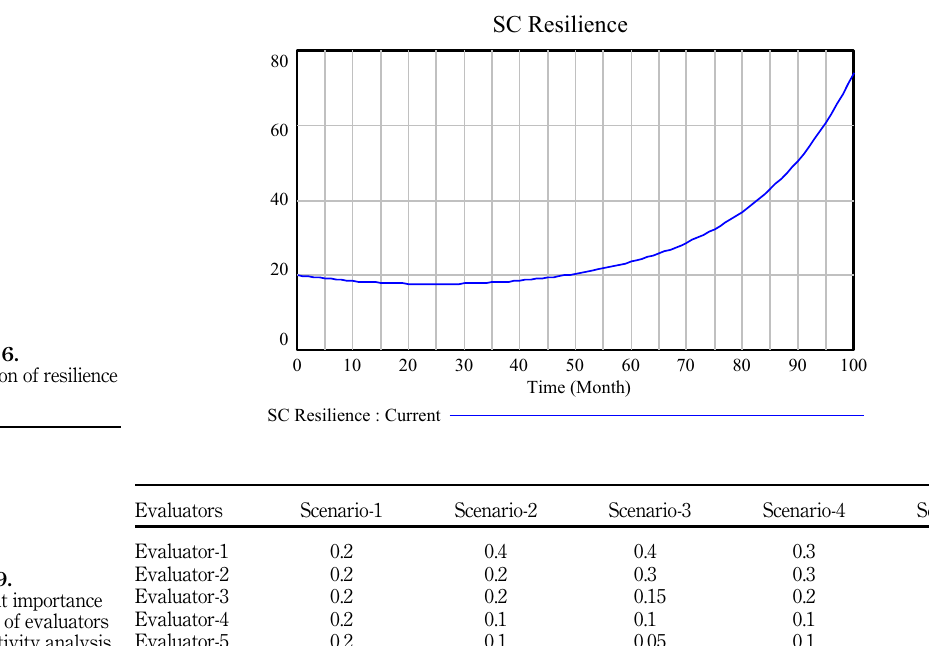
Table 9. Different importance weights of evaluators in sensitivity analysis